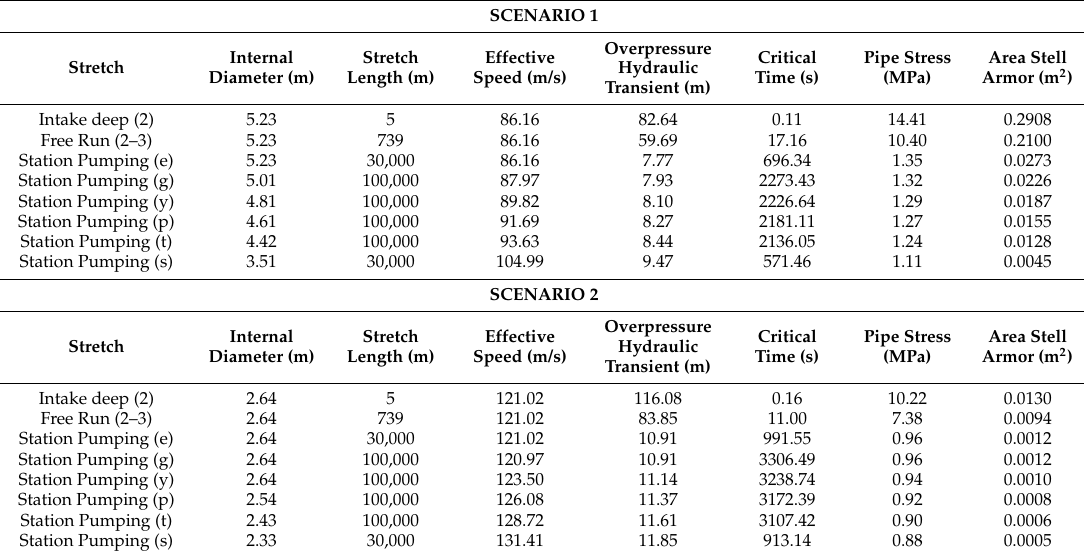
Table 11. Characterization of hydraulic transients for pipeline Nile-Tel Aviv/Gaza. Scenario 1 (200 L/capita/day), Scenario 2 (81